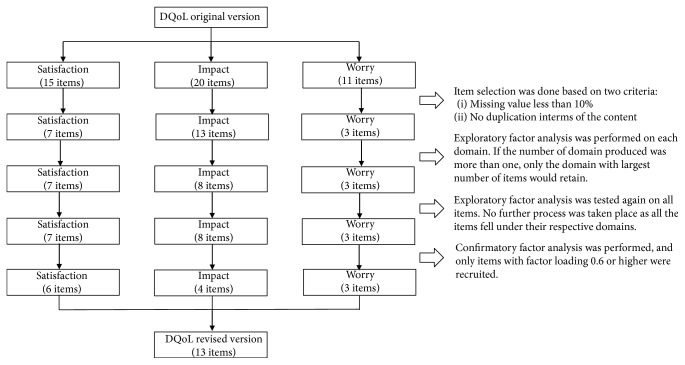
Flow of data analysis.